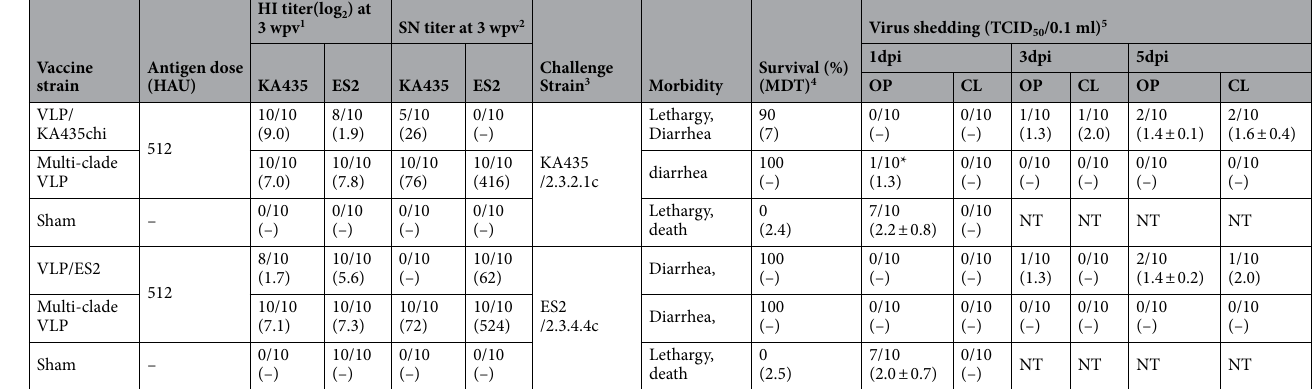
no reaction in cross SN test. After challenge with KA435/2.3.2.1c and ES2/2.3.4.4c, all vaccinated chickens pro- duced green stools and diarrhea, and some became lethargic. Virus shedding was detected from 1–5 dpi, with a swab samples. In the multi-clade VLP vaccinated groups, virus shedding was detected at 1 dpi in an OP sample from one chicken, with viral titer of 10 1.3 TCID 50 /0.1 mL, after challenge with KA435/2.3.2.1c; no virus shedding was detected in birds challenged with ES2/2.3.4.4c. In the sham groups challenged with KA435/2.3.2.1c and ES2/2.3.4.4c, virus shedding was detected at 1 dpi in seven chickens, with a viral titer of 10 2.0 –10 2.2 TCID 50 /0.1 mL only in the OP swab sample. There were significant differences ( p < 0.05 ) at 1 dpi in the viral titers in OP swab samples from sham-vaccinated chickens and SPF chickens vaccinated with the multi-clade VLP vaccine against KA435/2.3.2.1c (Table 2).